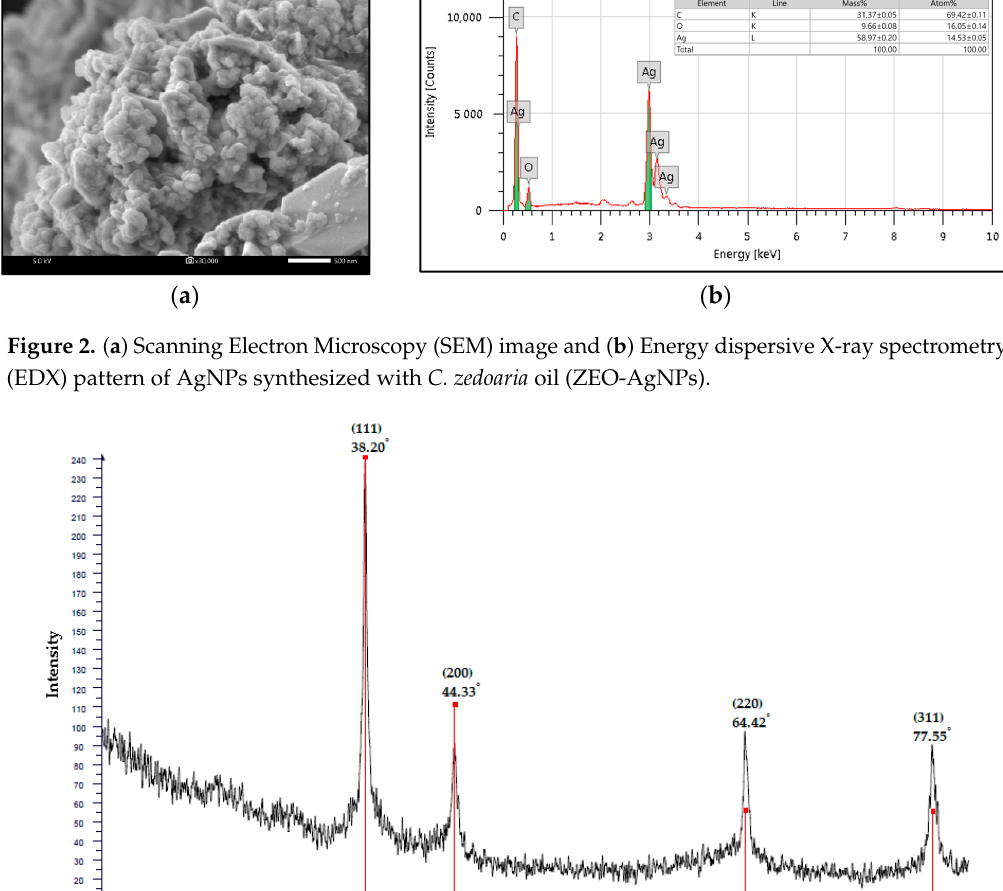
Figure 2. ( a ) Scanning Electron Microscopy (SEM) image and ( b ) Energy dispersive X-ray